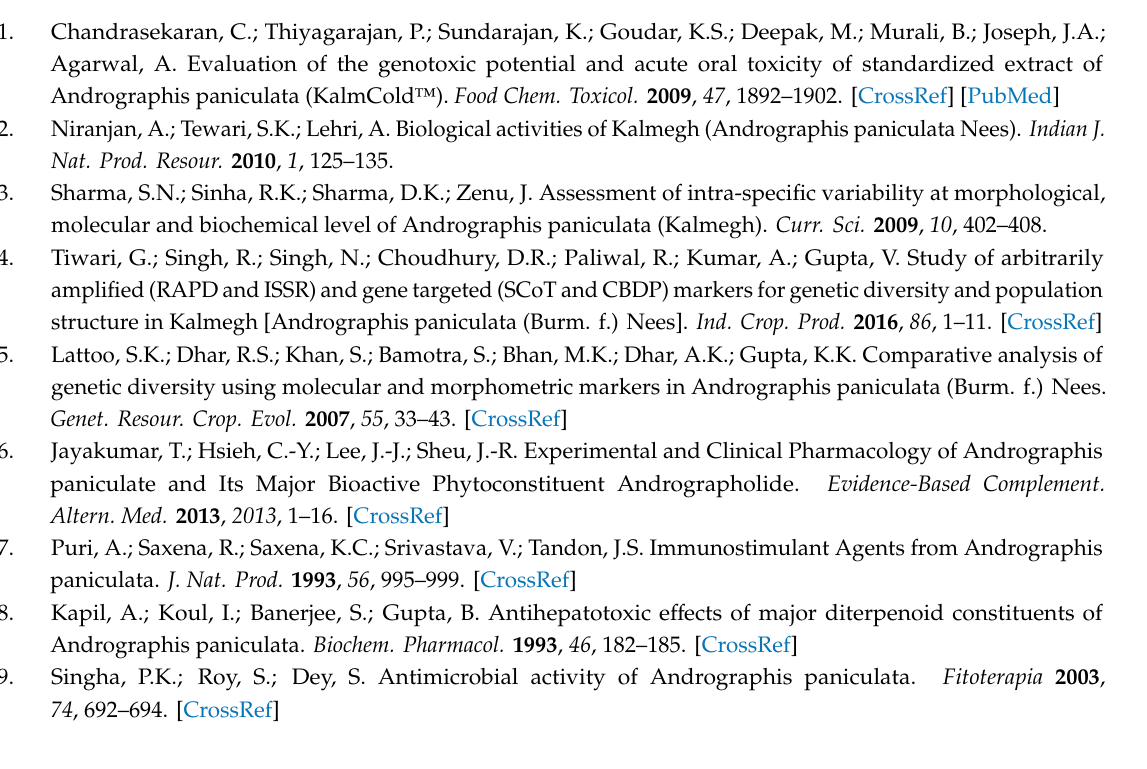
Figure S1: Analysis of molecular variance (AMOVA) of 42 accessions of Andrographis paniculata based on SSR marker data. Figure S2: Plot of mean likelihood L (K) and variance per K value from STRUCTURE on SSR dataset. Figure S3: Table output of the Evanno method results; yellow highlight is performed dynamically on the Structure Harvester online tool and shows the highest value in the Delta K column. Figure S4: Gel image of primer Ando4-34-1 among the 42 accessions of A. paniculate ; M = 100 bp marker; polymorphic bands are indicated with a yellow arrow. Figure S5: Gel image of primer Ando2-40-2 among the 42 accessions of A. paniculata . Figure S6: Gel image of primer Ando4-26 among the 42 accessions of A. paniculata . Figure S7: Relationship between genetic and geographic distances for 42 A. paniculata accessions. Table S1: Nanodrop DNA quantification result of 42 A. paniculata accessions. Table S2: Mean value of Fst1, Fst2, Fst3, and alpha concluded from a model-based approach. Table S3: Allele-frequency divergence among populations of A. paniculata accessions. Table S4: Percentage of variation explained by the first three axes among the A. paniculata accessions. Table S5: Mantel results for geographic distance vs. genetic